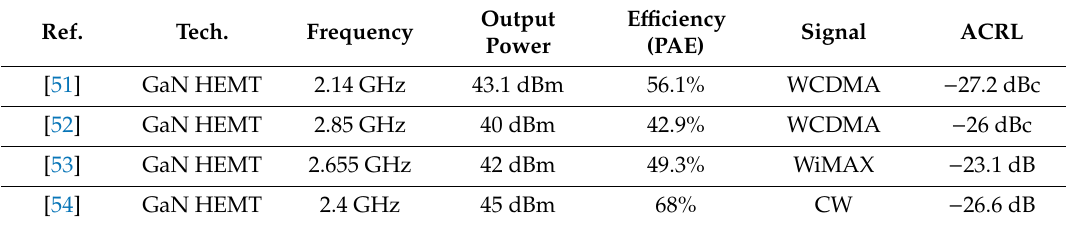
Table 6. Performance summary of Class-E Doherty Amplifiers operation